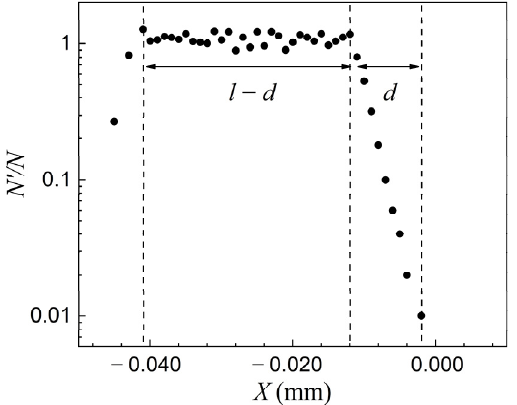
Figure 6. Plot of normalized upset counts in the horizontal direction.